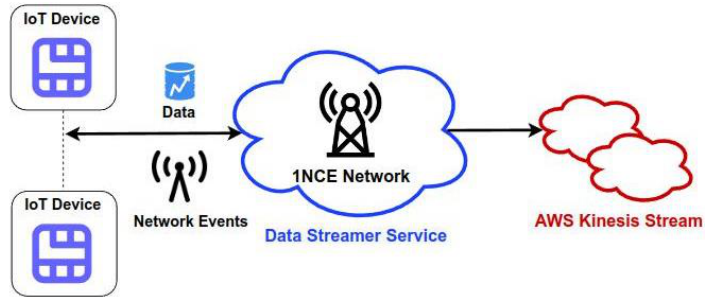
Figure 31. Data usage streams from 1NCE/Ubirch to AWS metrics platform.